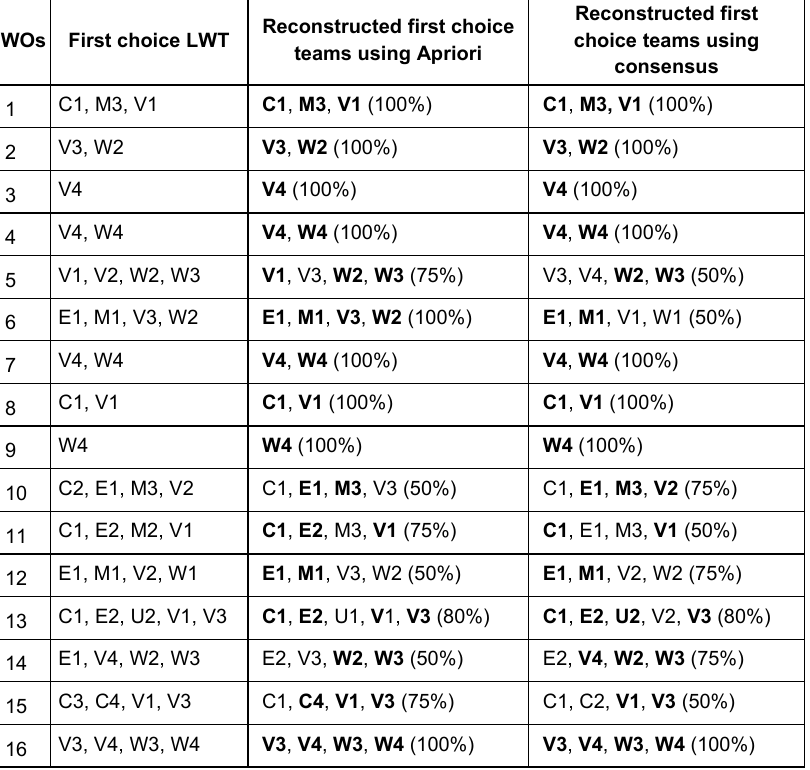
Table 6. First choice teams and their reconstruction